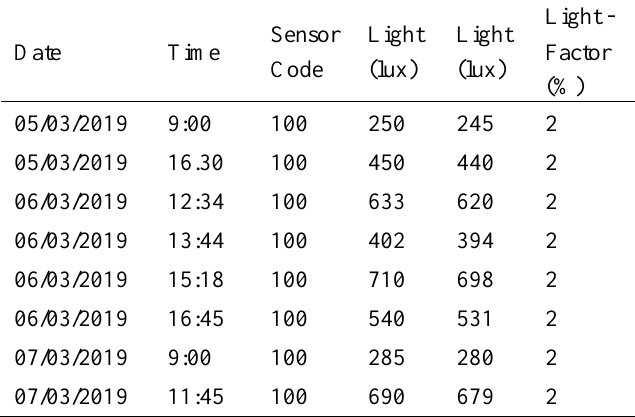
Calibration readings